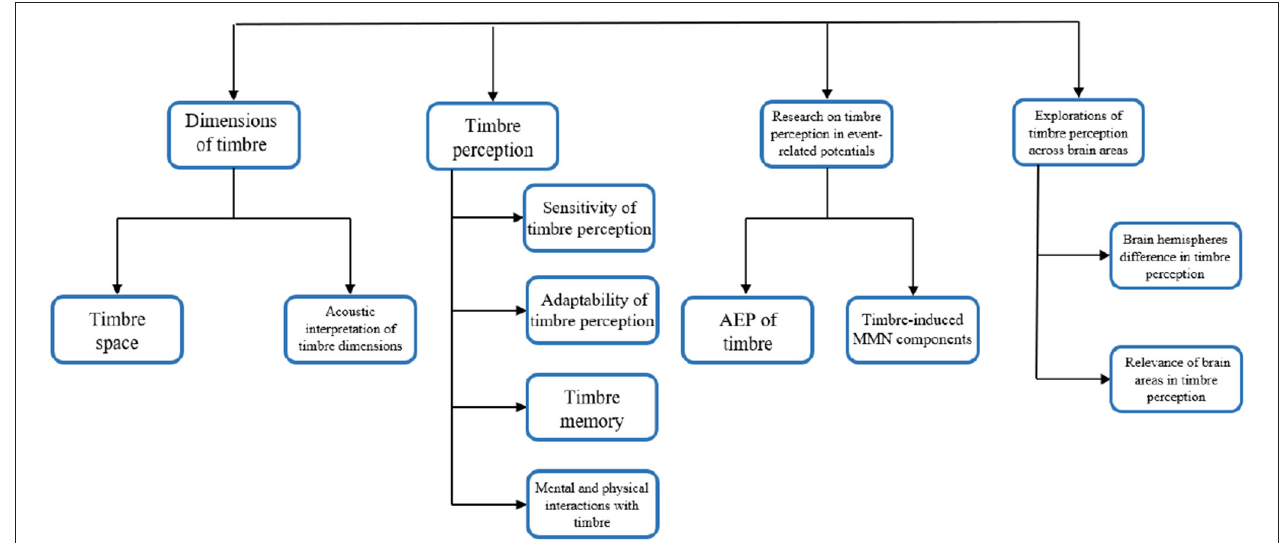
FIGURE 1 | Overall structural diagram of this